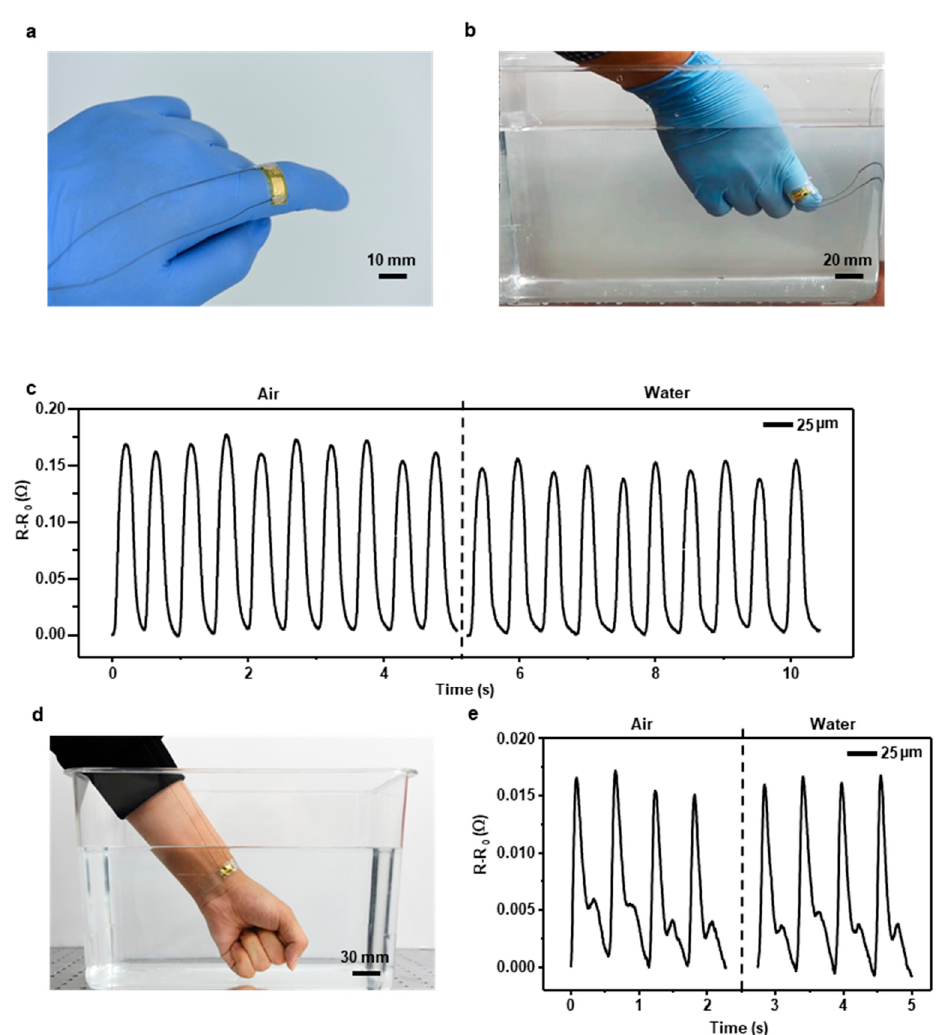
Figure 4. ( a ) Overall image of the FEP encapsulated sensor mounted on a finger. ( b ) Underwater motion test to measure the actions of the finger. ( c ) Performance of the sensor that measured the finger’s motions in air and water. ( d ) Underwater vital sign test to measure pulse rate in water. ( e ) Performance of the sensor that measured pulse rate in air and water.